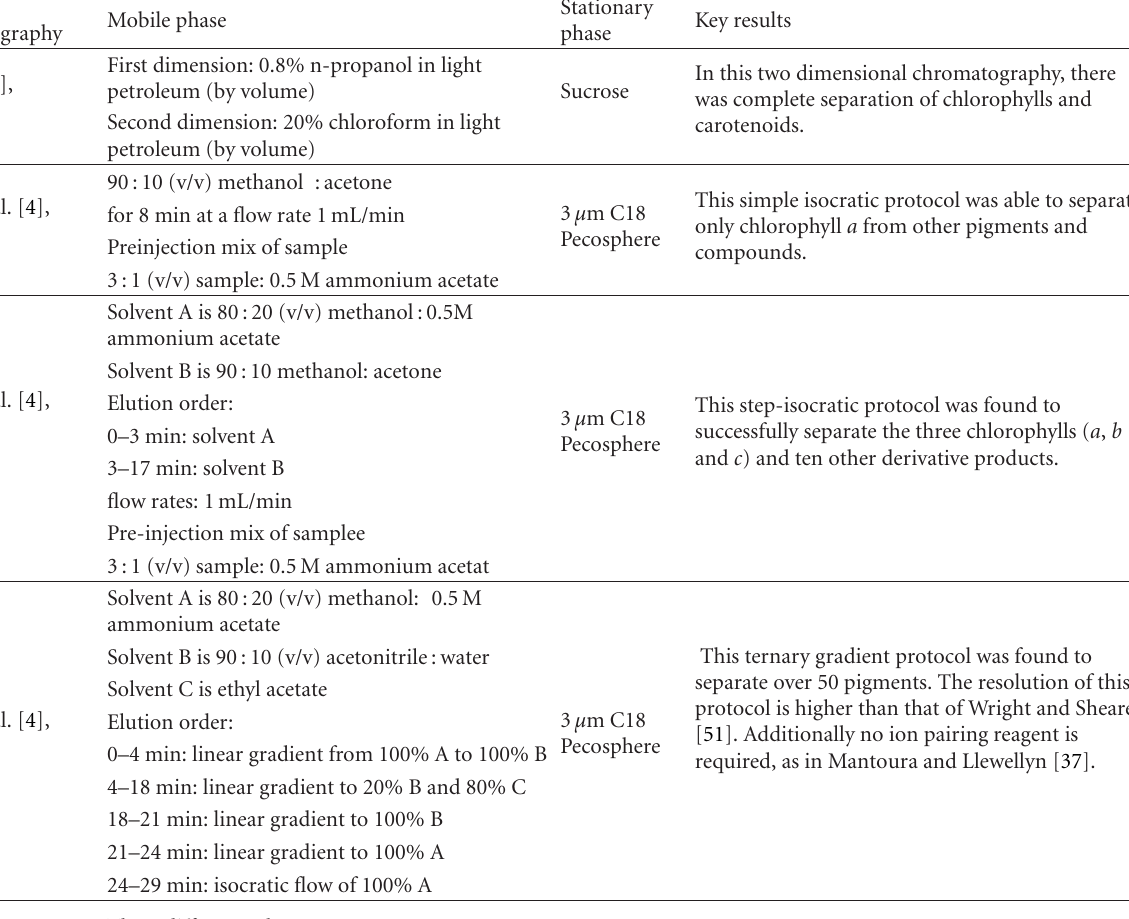
Table 4: Previous studies on HPLC fractionation of chlorophylls extracted from phytoplanktons.